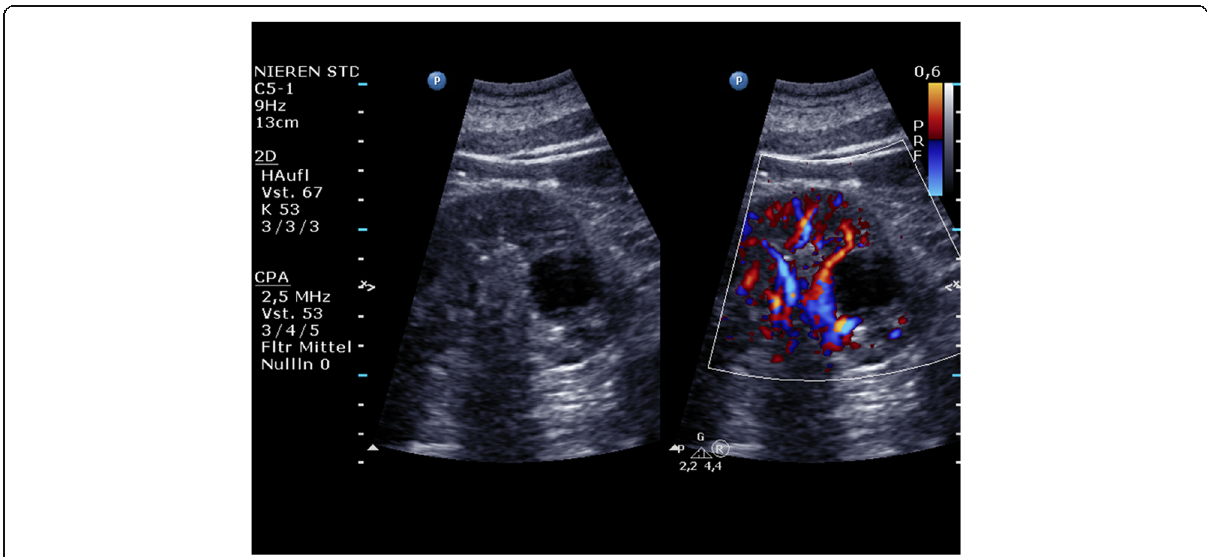
Fig. 1 Philips Healthcare CX50: A renal cyst (left) that shows thin walls without any septa, calcifications, solid components, or contrast enhancement. There is no vascularisation of the cyst visible in colour Doppler mode (right)